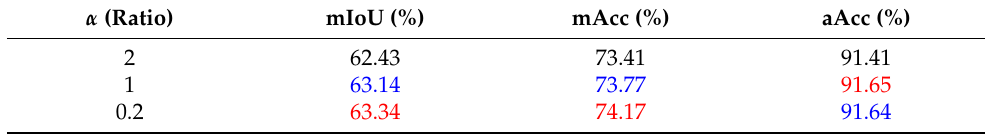
Table 6. Experiment results obtained by selecting different loss